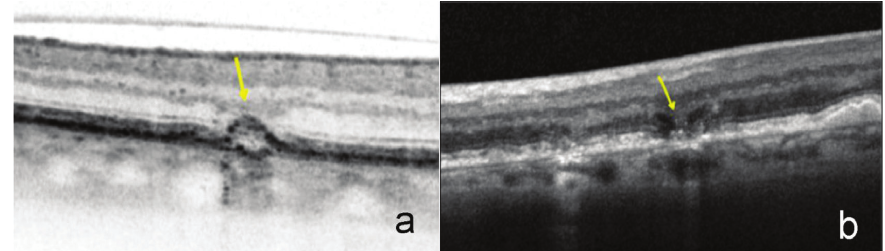
Figure 1: SD-OCT features. (a) B-scan of SD-OCT where drusen with hypertransmission are observed; (b) B-scan of SD-OCT showing nascent geographic atrophy.